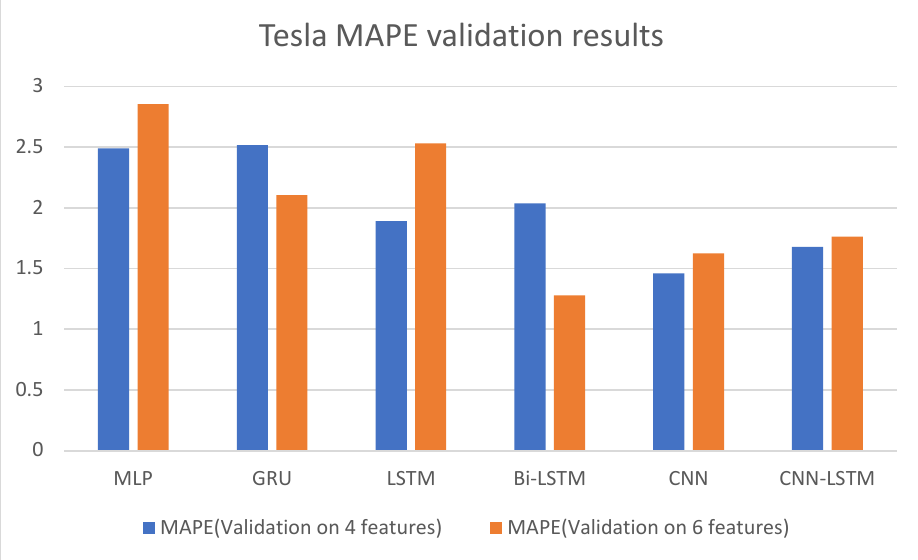
Figure 8. The visualization of the MAPE results for Tesla .